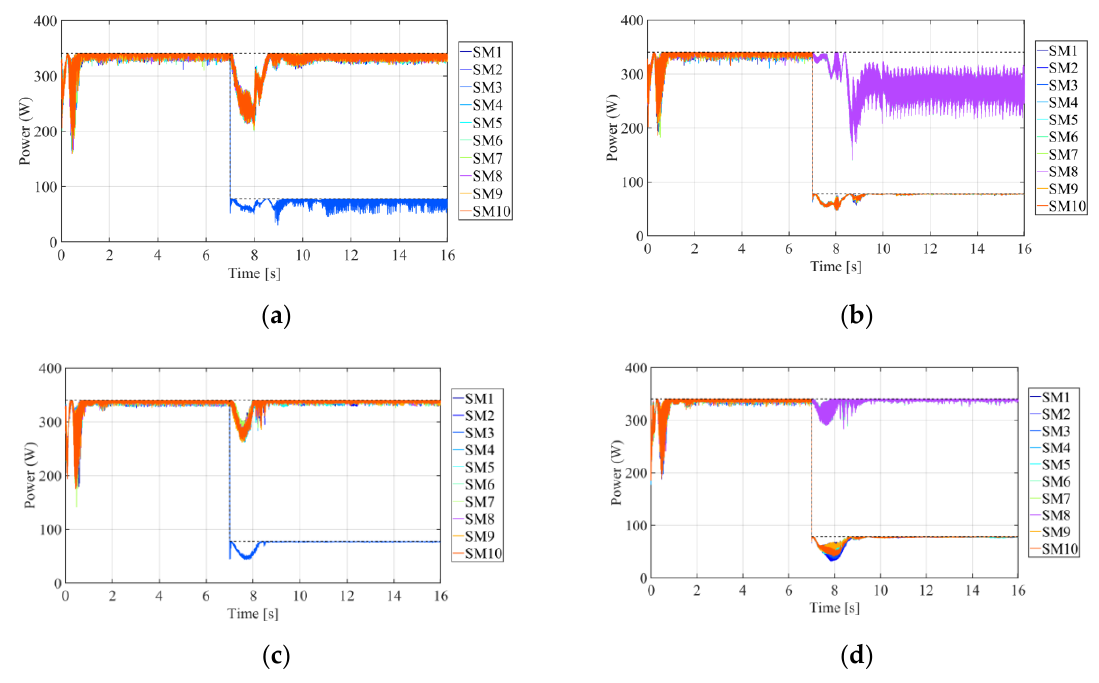
Figure 10. PV module powers: ( a ) CMPPT control—upper arm; ( b ) CMPPT control—lower arm; ( c ) DMPPT control—upper arm; ( d ) DMPPT control—lower arm. The dashed lines represent the maximum available power.